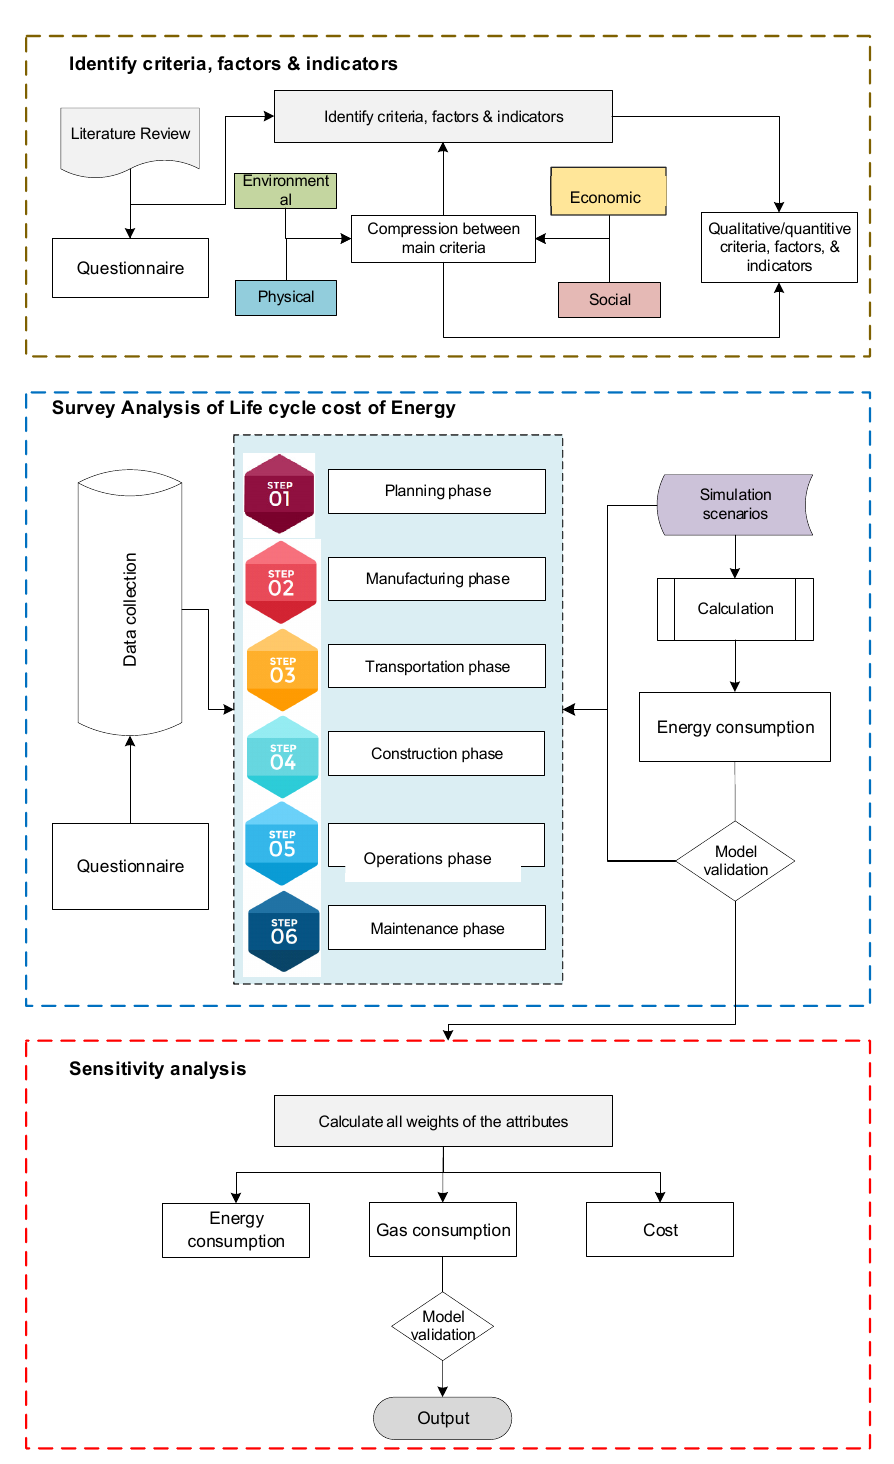
Figure 1. Framework of heritage buildings life-cycle cost of energy.